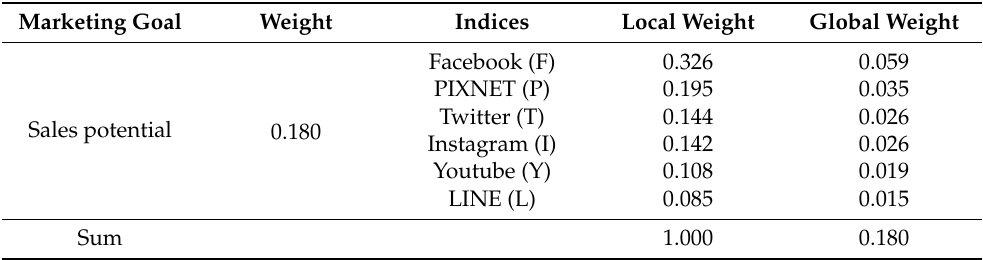
Table 4. AHP sales potential and complimentary social media analysis.